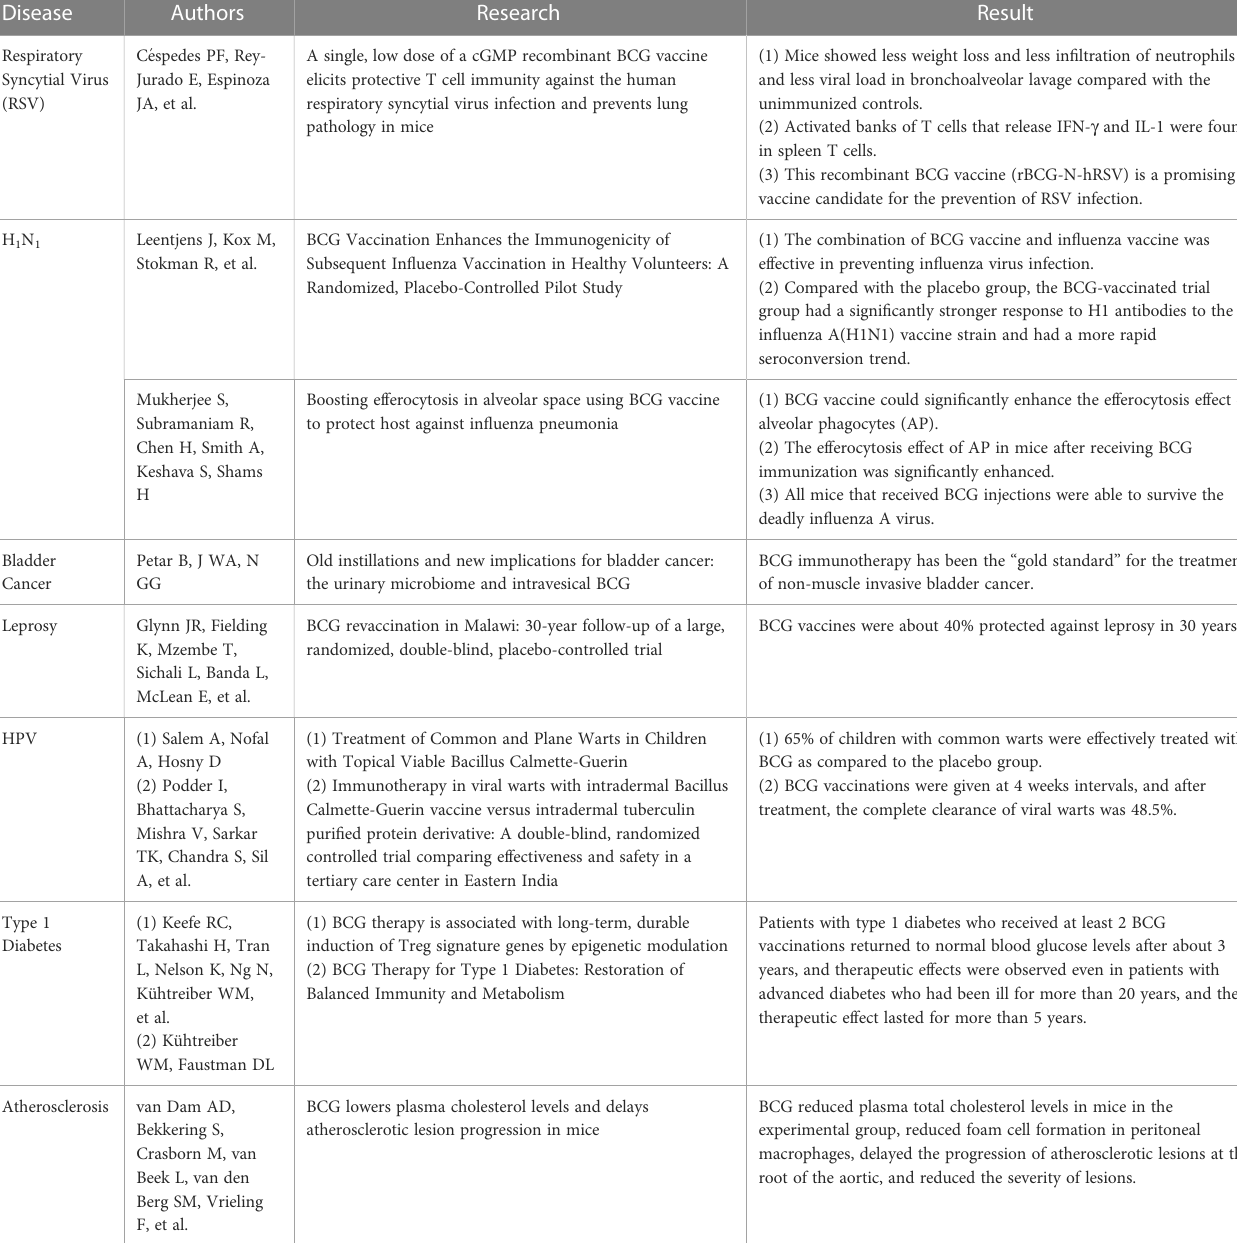
TABLE 2 Effect of BCG on other diseases rather than